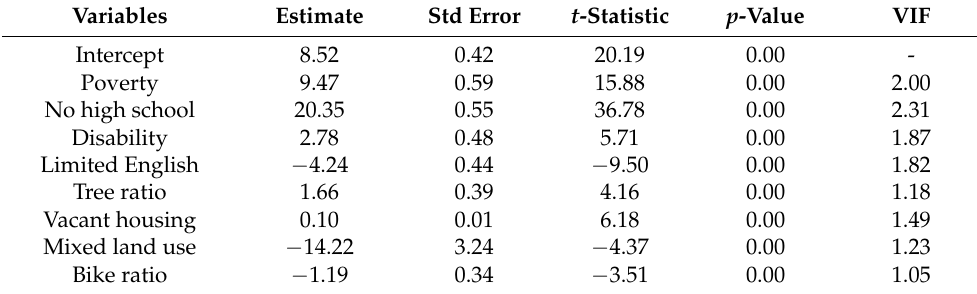
Table 2. OLS Model